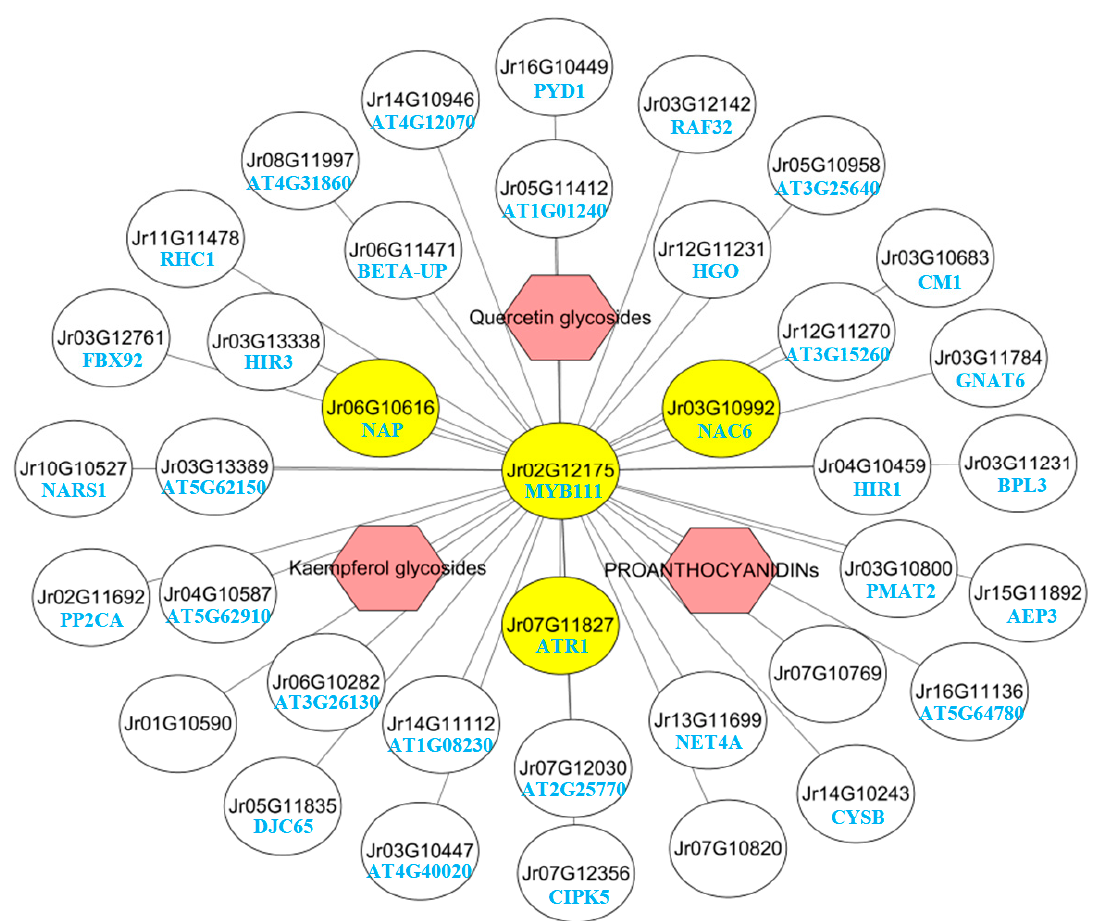
Figure 8. Co ‐ expression network for MYB111 (Jr02G12175). Using the WGCNA filtered gene list, we ranked the genes based on the weighted correlation weight with MYB111 (Jr02G12175), and selected the top 37 genes from the blue module. The yellow solid circles represent transcription factors and the red hexagons represent major metabolites. The function of the genes is described in Table S4. Comparing the transcriptome data of endopleura with embryo [36], the expression Besides, PMAT2 (Jr03G10800) belongs to the HXXXD ‐ type acyltransferase family, levels of these genes in endopleura were much higher than those in embryos. These results support that the tissue-specific expression of these polyphenol-related genes resulted in the higher polyphenol content in endopleura than in embryos. The unigenes, PAL (Jr02G11537), C4H (Jr14G11389), CHS (Jr01G10656 and Jr02G10304), F3H (Jr07G12902), F3 (cid:48) H (Jr11G12560), LDOX (Jr11G11451), and ANR (Jr09G12363), were all expressed at the highest level in the mature endopleura. The high expression of structural genes was the reason why walnut endopleura was rich in